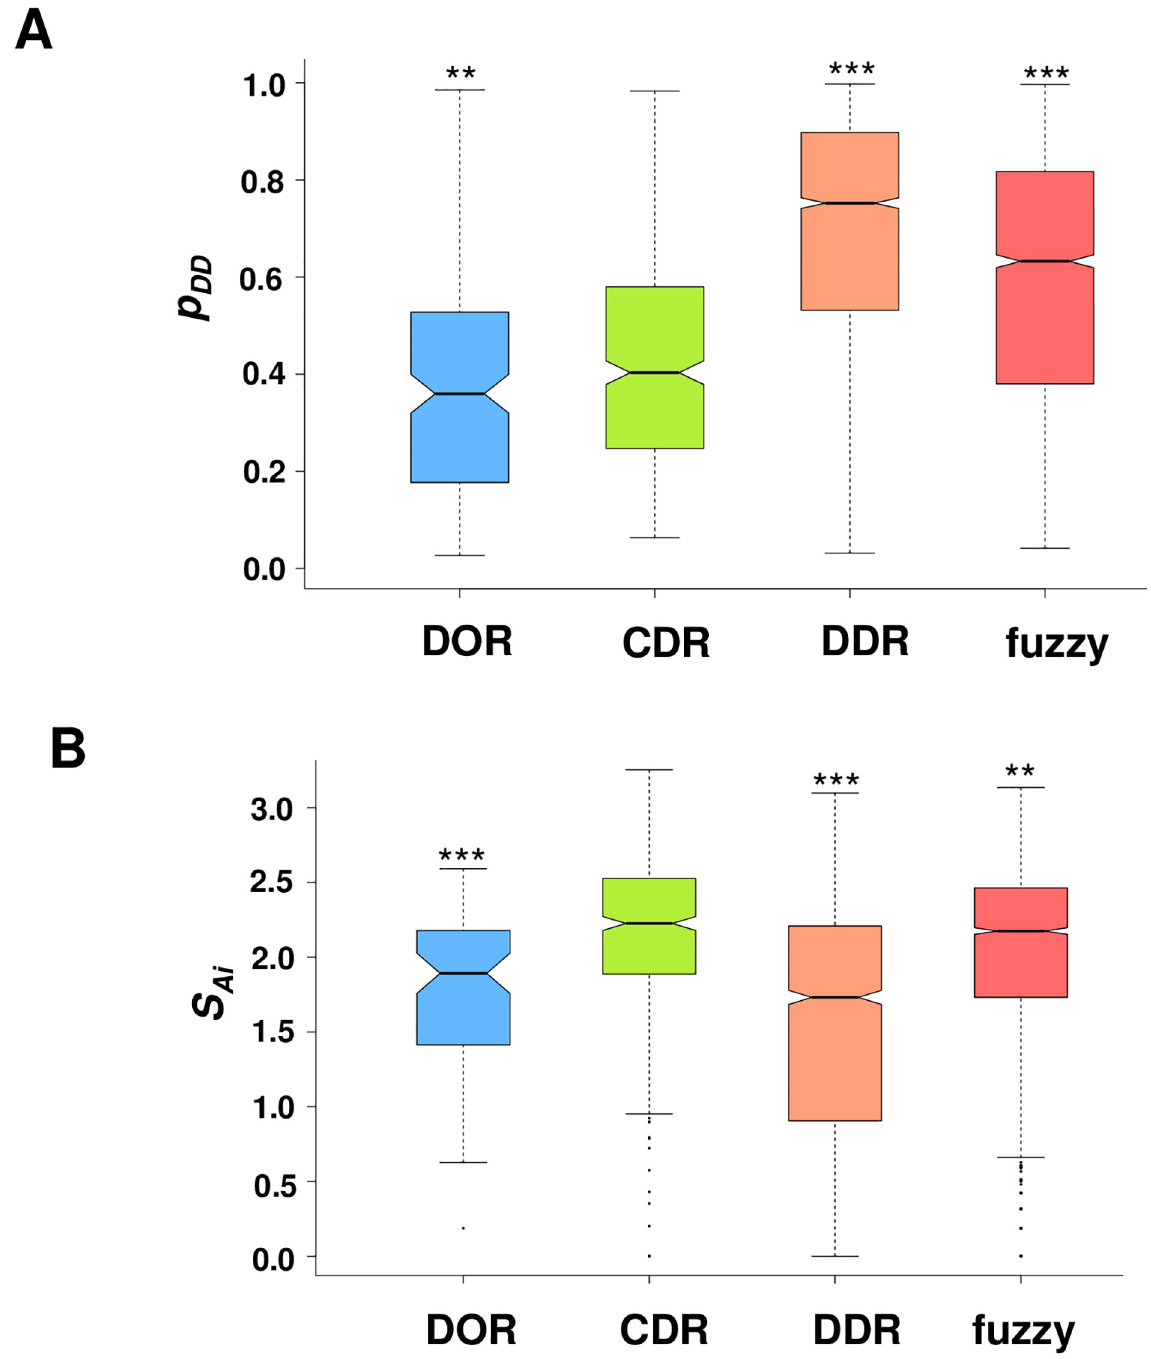
Fig 3. Predicted binding modes of disorder-to-order (DOR), context-dependent (CDR), disorder-to-disorder (DDR) and fuzzy regions. (A) Binding mode probabilities. The probabilities of disorder-to-disorder transitions are shown for DOR (blue), CDR (lime), DDR (salmon) and fuzzy (red) regions. The p DD values indicate significantly elevated disorder for interactions of DDRs and fuzzy regions as compared to values for DOR (blue), CDR (lime), and DDR (salmon) regions significantly DORs and CDRs. (B) Shannon entropy of binding modes. S A i differ between these binding modes. Context-dependent regions exhibit the highest binding mode diversity as compared to DORs and DDRs. Fuzzy, disordered binding regions (from the Fuzzy Complexes Database [25]) also have elevated S values indicating their context dependence. A i Statistical significances were determined by Mann-Whitney tests as implemented in the R program. p values as compared to CDRs are shown ( �� p < 10 − 2 ; ��� p < 10 − 5